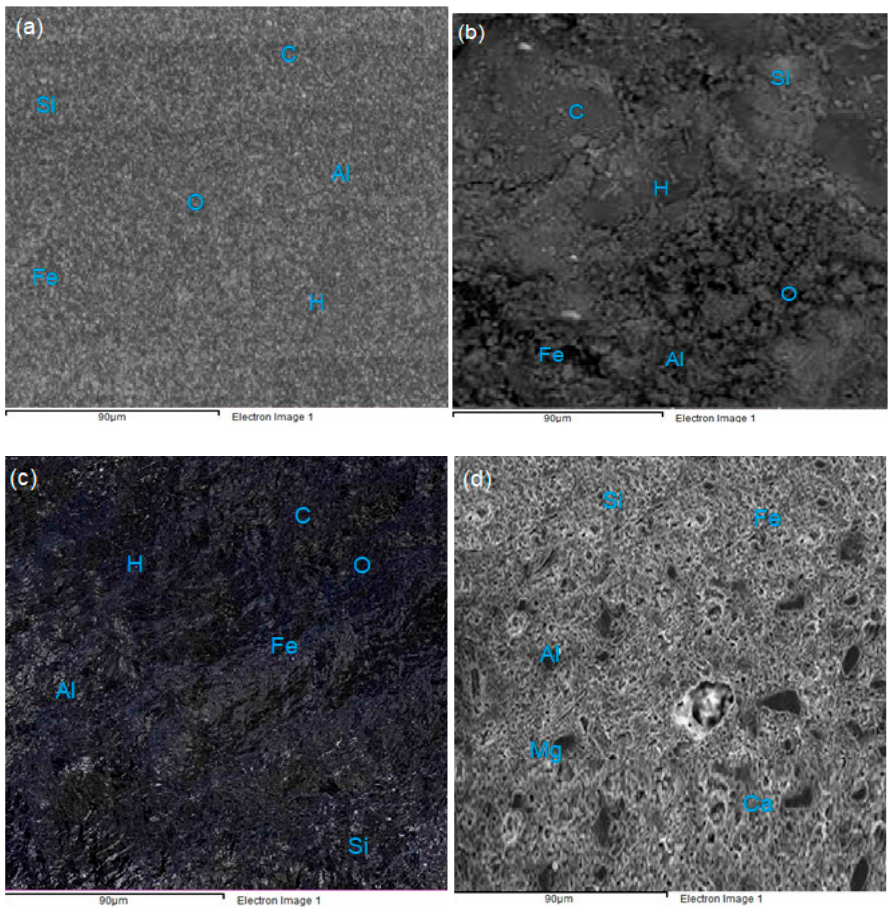
Figure 11. ( a – d ) The micrographs obtained by SEM of PW and fired clay bricks.